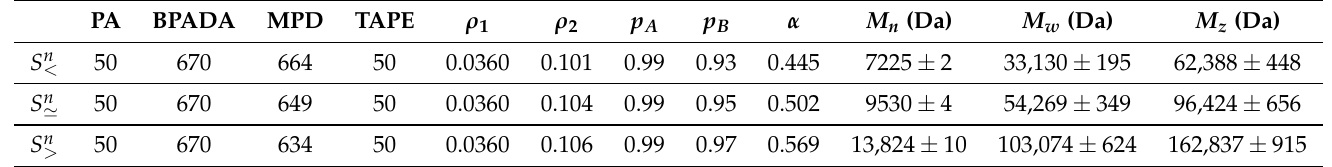
Table 5. Three partially reacted, nonstoichiometric systems (i.e., p A (cid:54) = p B , and both are less than 1) below, around, and beyond the gel point. The entries have the same format as in Table 2. The